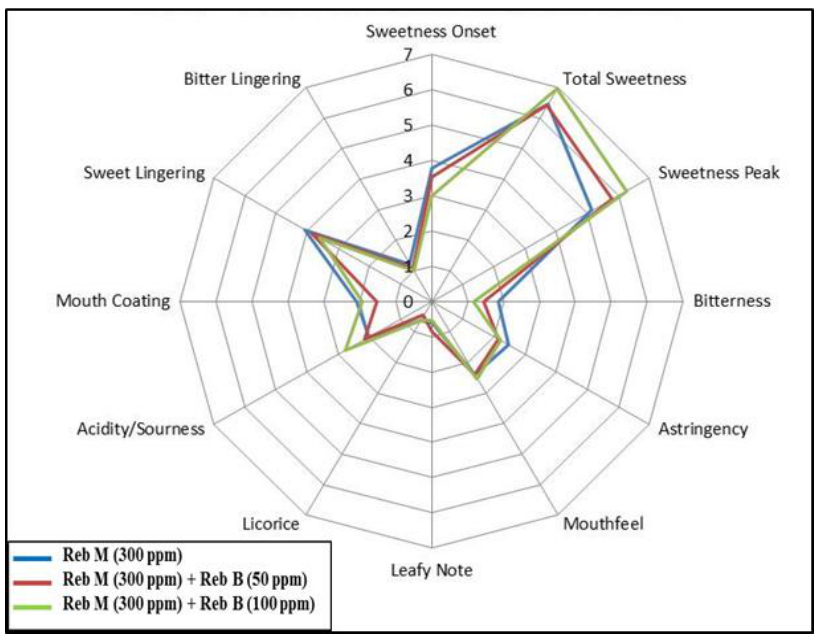
Figure 8. Sensory profile of di-blends of rebaudioside M ( 7 ) and rebaudioside B in acidified